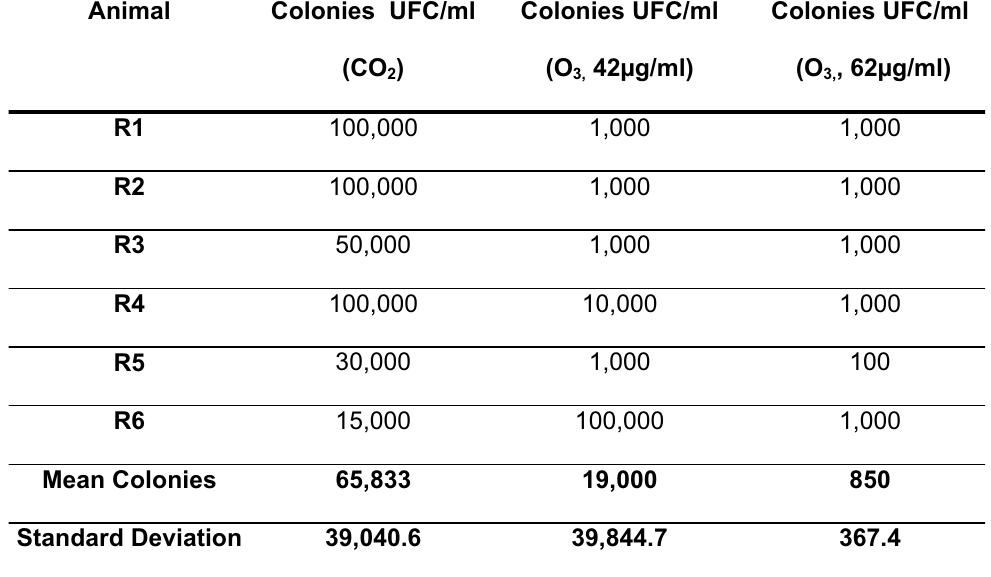
TABLE 1 - Number of E.coli ATCC colonies in UFC/ml obtained after CO pneumoperitoneum